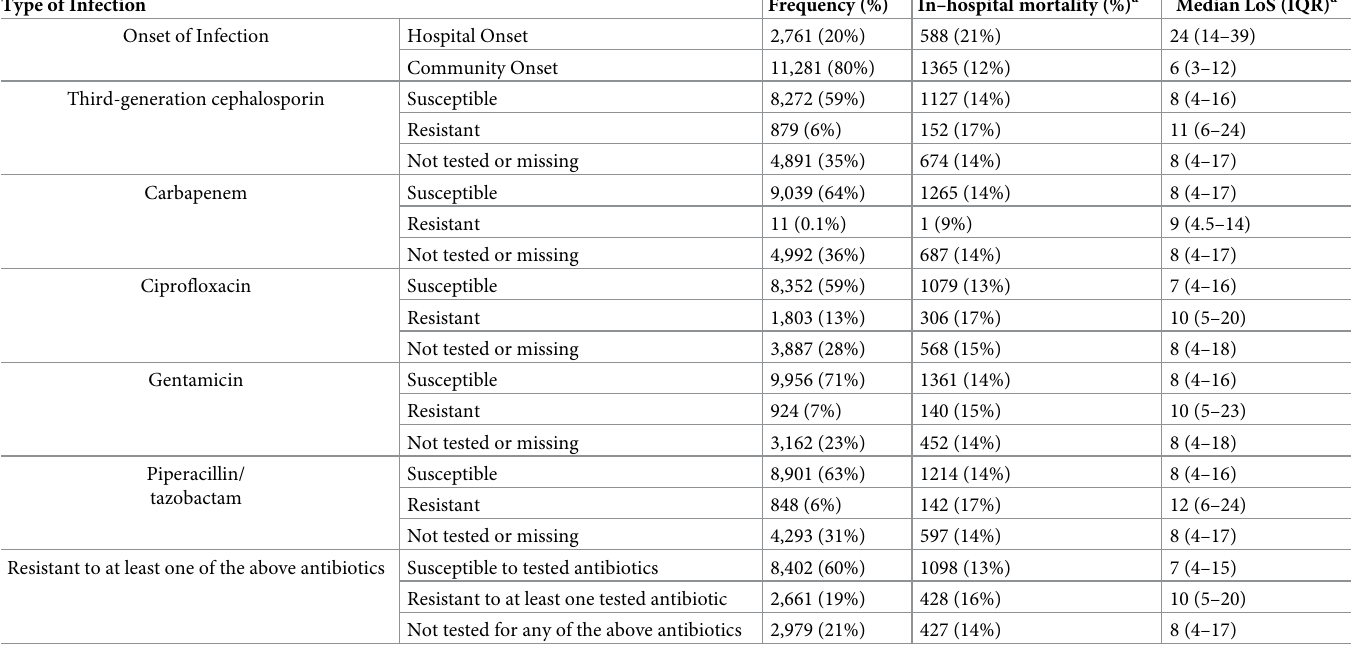
Table 2. Descriptive statistics by infection type.